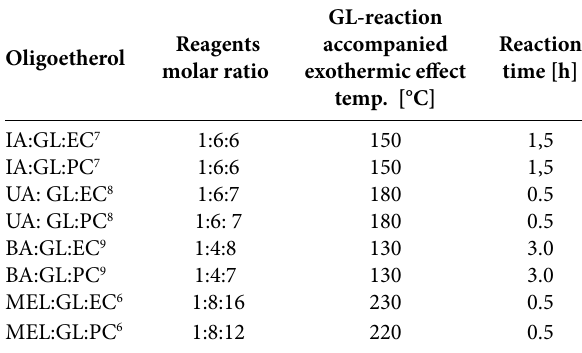
Table 1. Exothermic effects accompanying the reaction of azacycles with GL in two-steps synthesis of oligoetherols (the starting amount of azacycle was 0.05 mole)